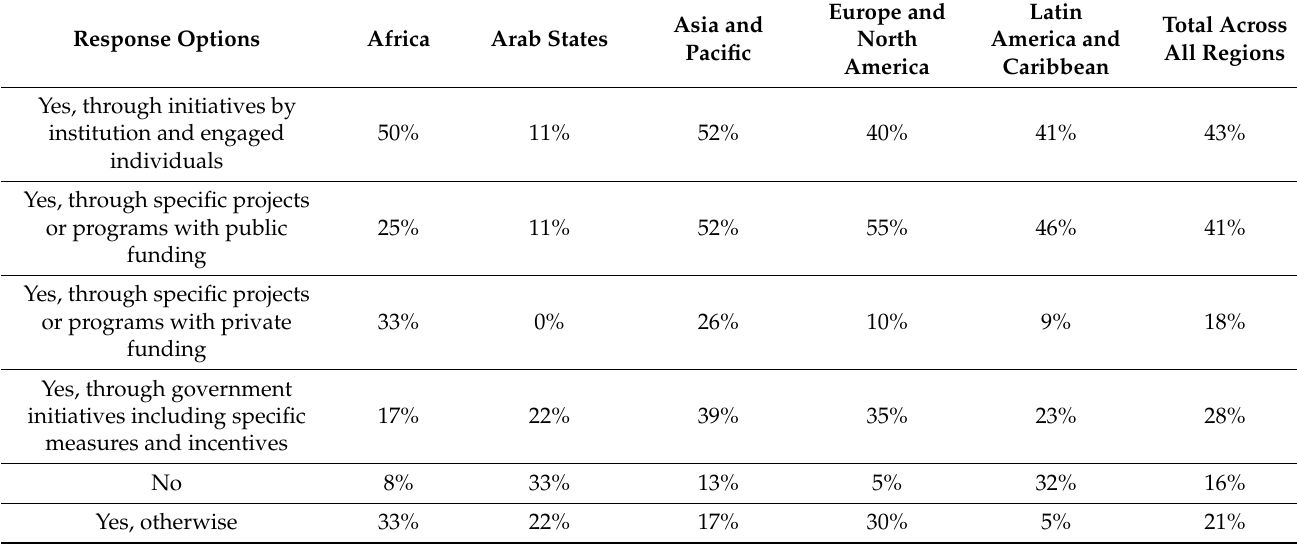
Table 1. Nature of OER activity per region.